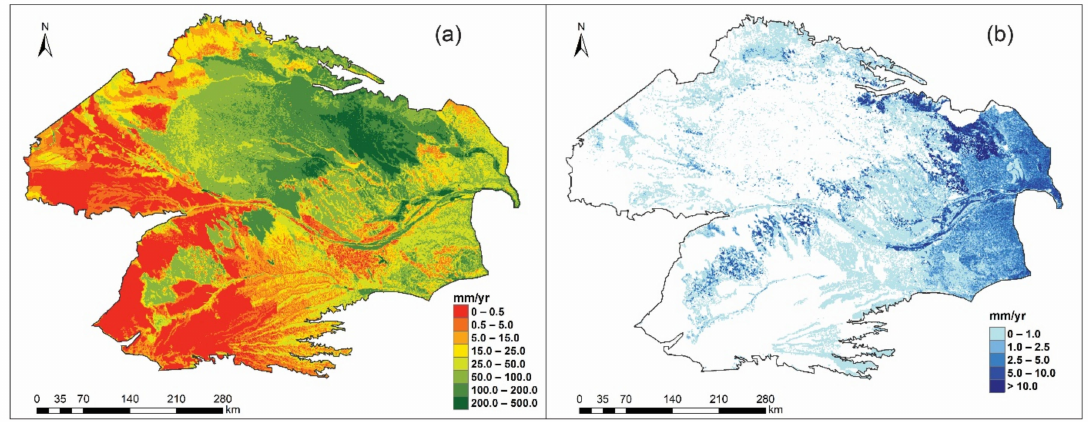
Figure 8. Auto-Irr estimated long term (1982–2008) average ( a ) mean annual recharge, and ( b ) differ- ence in annual recharge between irrigation and no-irrigation scenarios.